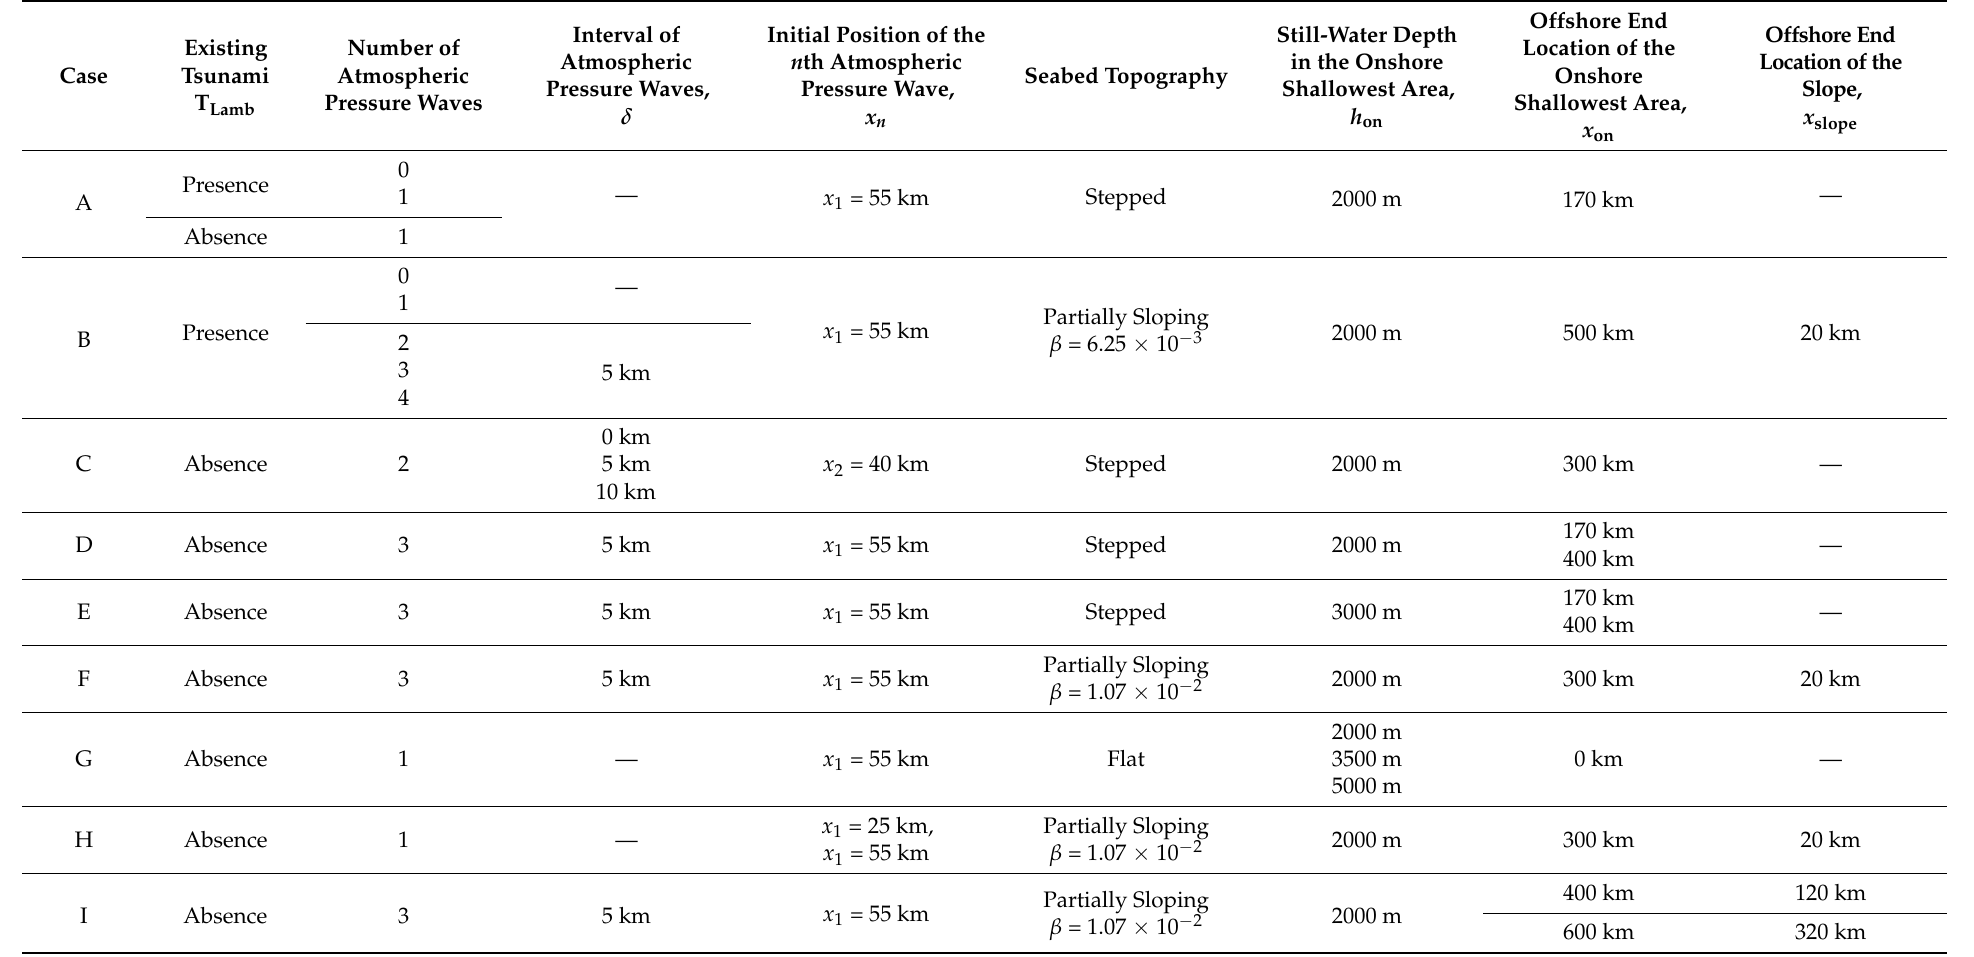
Table 1. Calculation conditions. The traveling velocity v p of every atmospheric pressure wave was 250 m/s. The uniform still-water depth in the offshore deepest area, h off , was 5000 m. The slope gradient is β